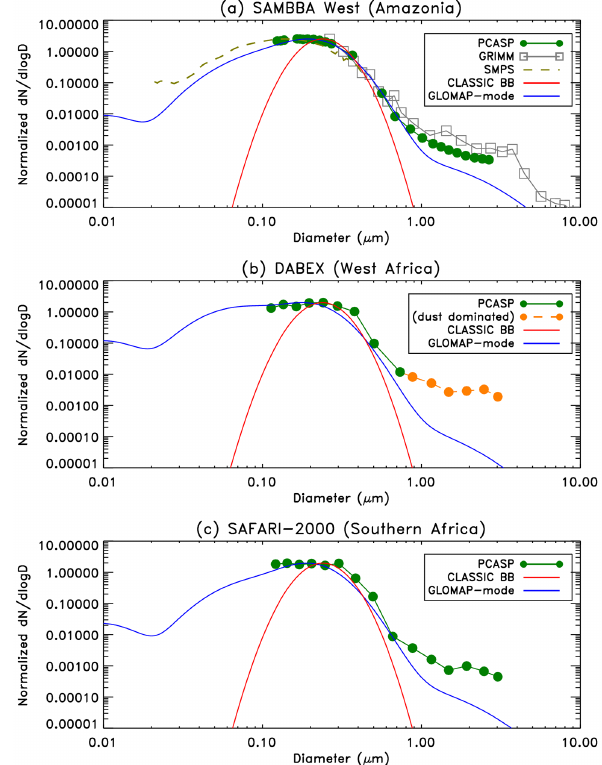
Figure 8. Aerosol number size distributions (dN/dlogD) vs. parti- cle diameter from aircraft observations (PCASP, GRIMM, SMPS) showing the mean distribution from three campaigns. CLASSIC curve is a representative mixture of 10% fresh and 90% aged BBA species; GLOMAP-mode is the complete size distribution over all five modes averaged over the flight regions in Fig. 1 and over 0–